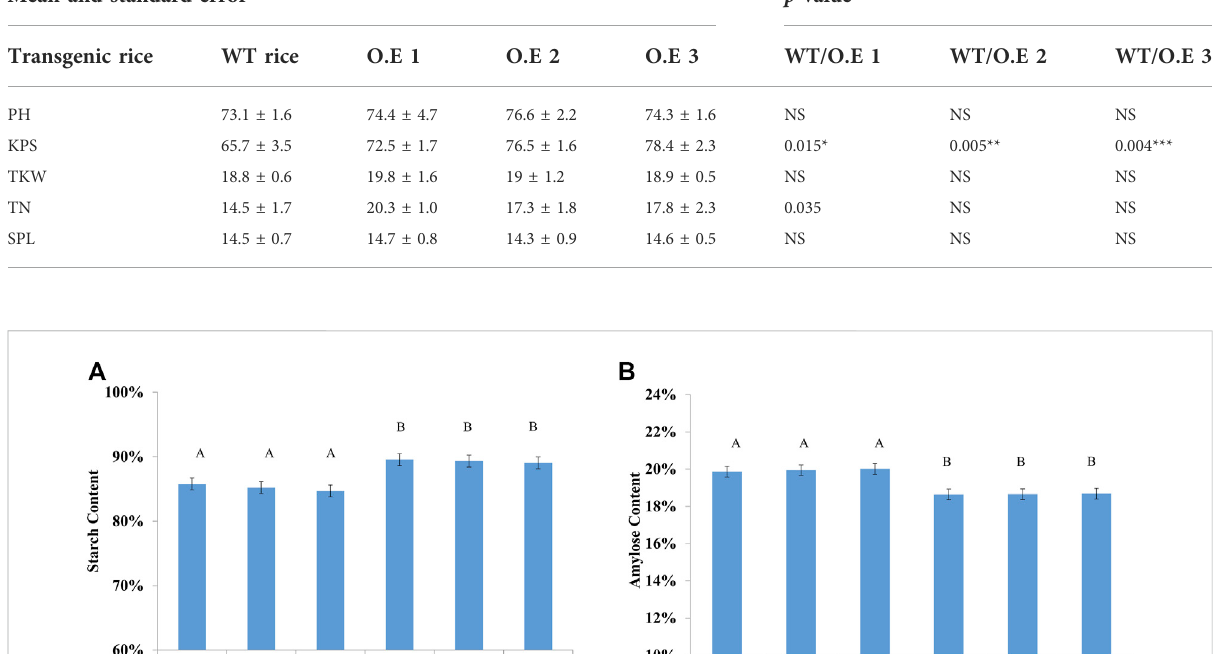
TABLE 1 Descriptive statistics based on mean and standard error for over-expressing transgenic rice lines to wild type. WT, wild type; O.E 1 – O.E 3, transgenic rice lines; PH, plant height; KPS, kernel per spike; TKW, thousand kernel weight; TN, tiller number; SPL, spike length, NS, non- signi fi cant.